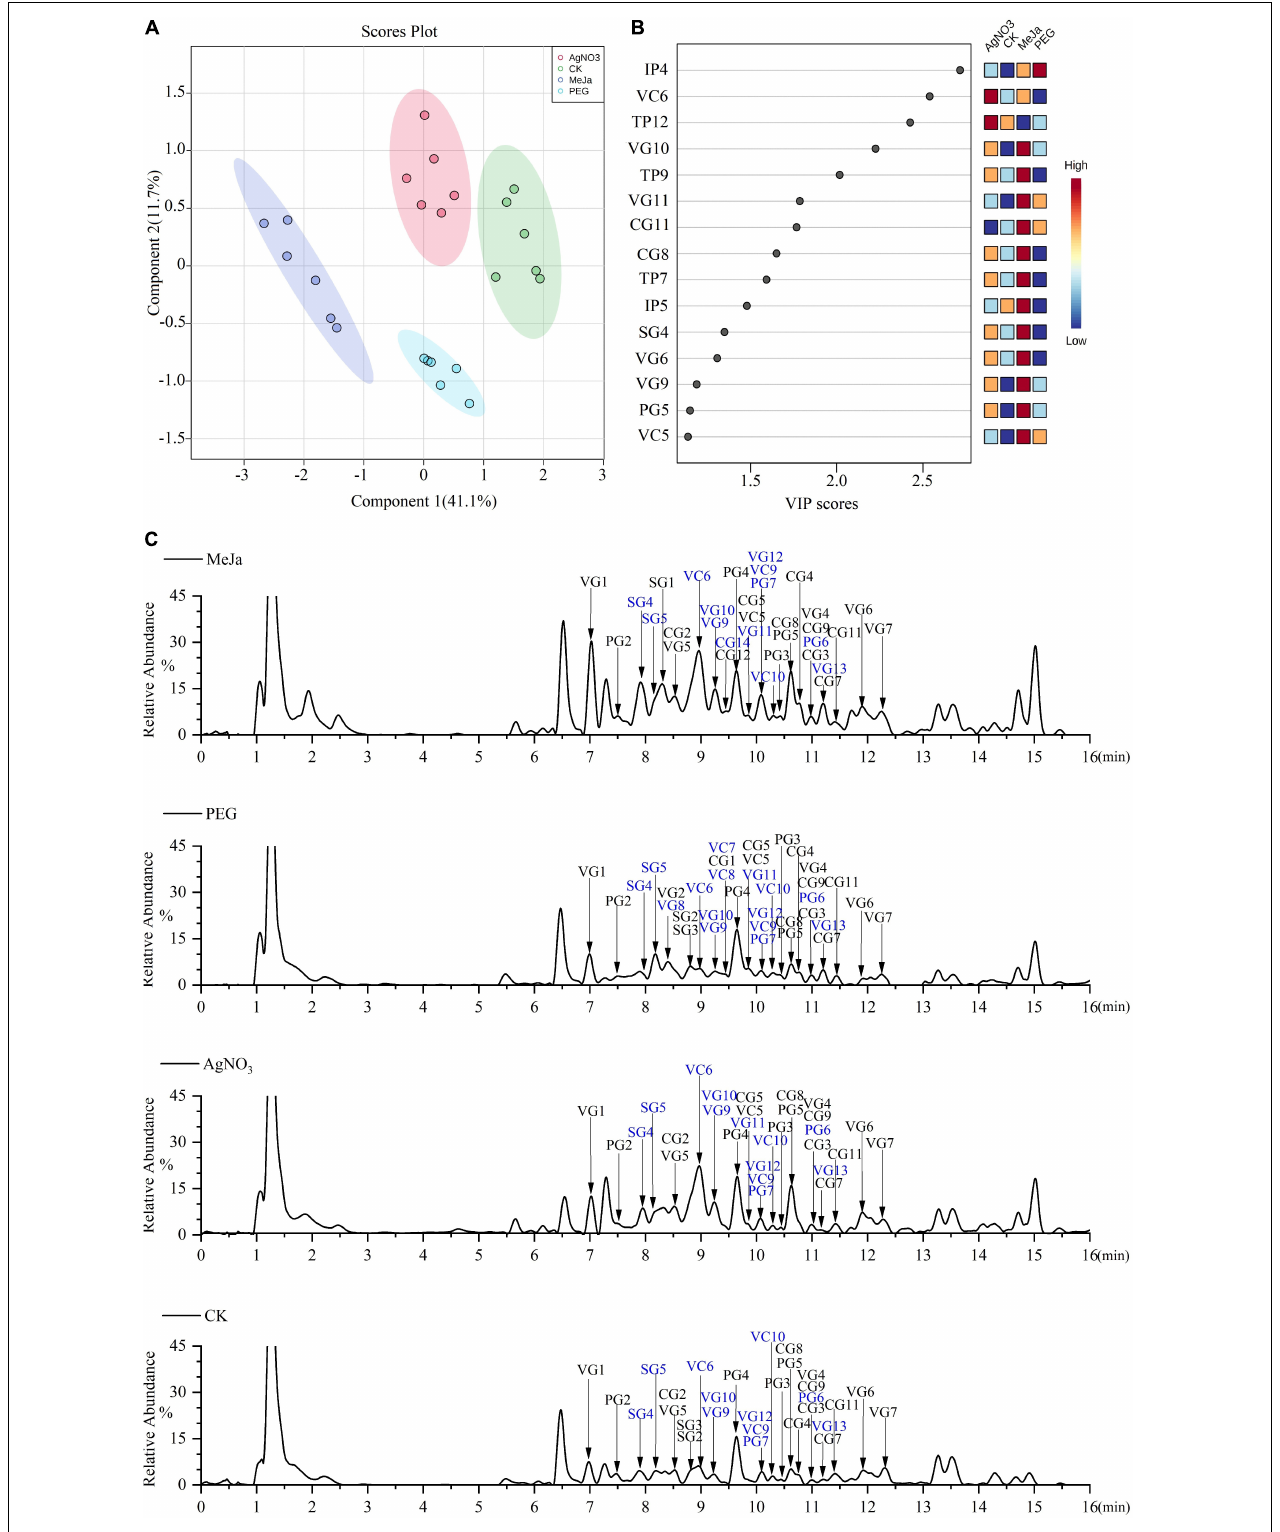
FIGURE 6 | Comparative analysis at the metabonomic level for the elicitation and control groups. (A) PLS-DA score plot. (B) The discriminating metabolites. (C) Total ion chromatograms (TIC) in the positive mode for representative samples. New alkaloids are marked in blue. MeJa, methyl jasmonate; AgNO 3 , silver nitrate; PEG, polyethylene glycol-20000; CK, control